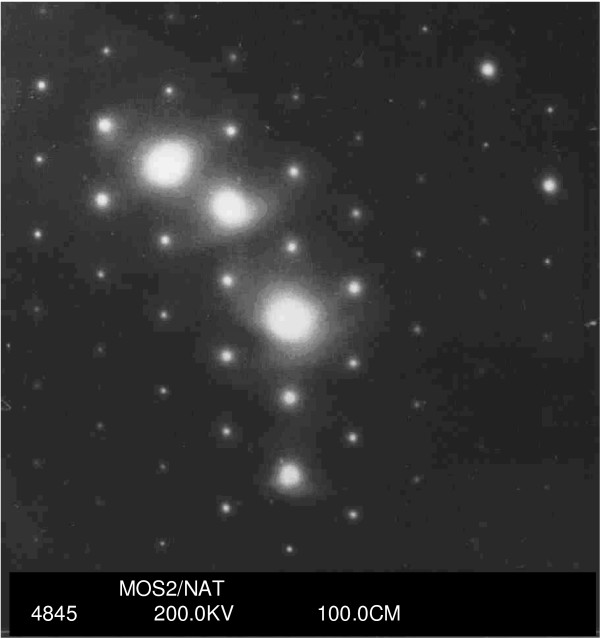
Electron diffraction diagram of molybdenite (2H-MoS2 polytype) showing the hexagonal lattice.